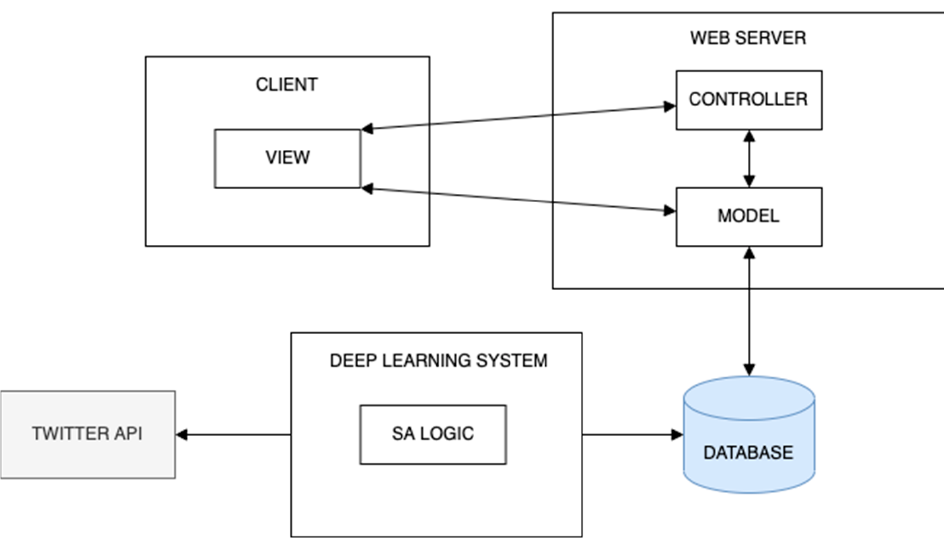
Figure 7. Web application diagram.